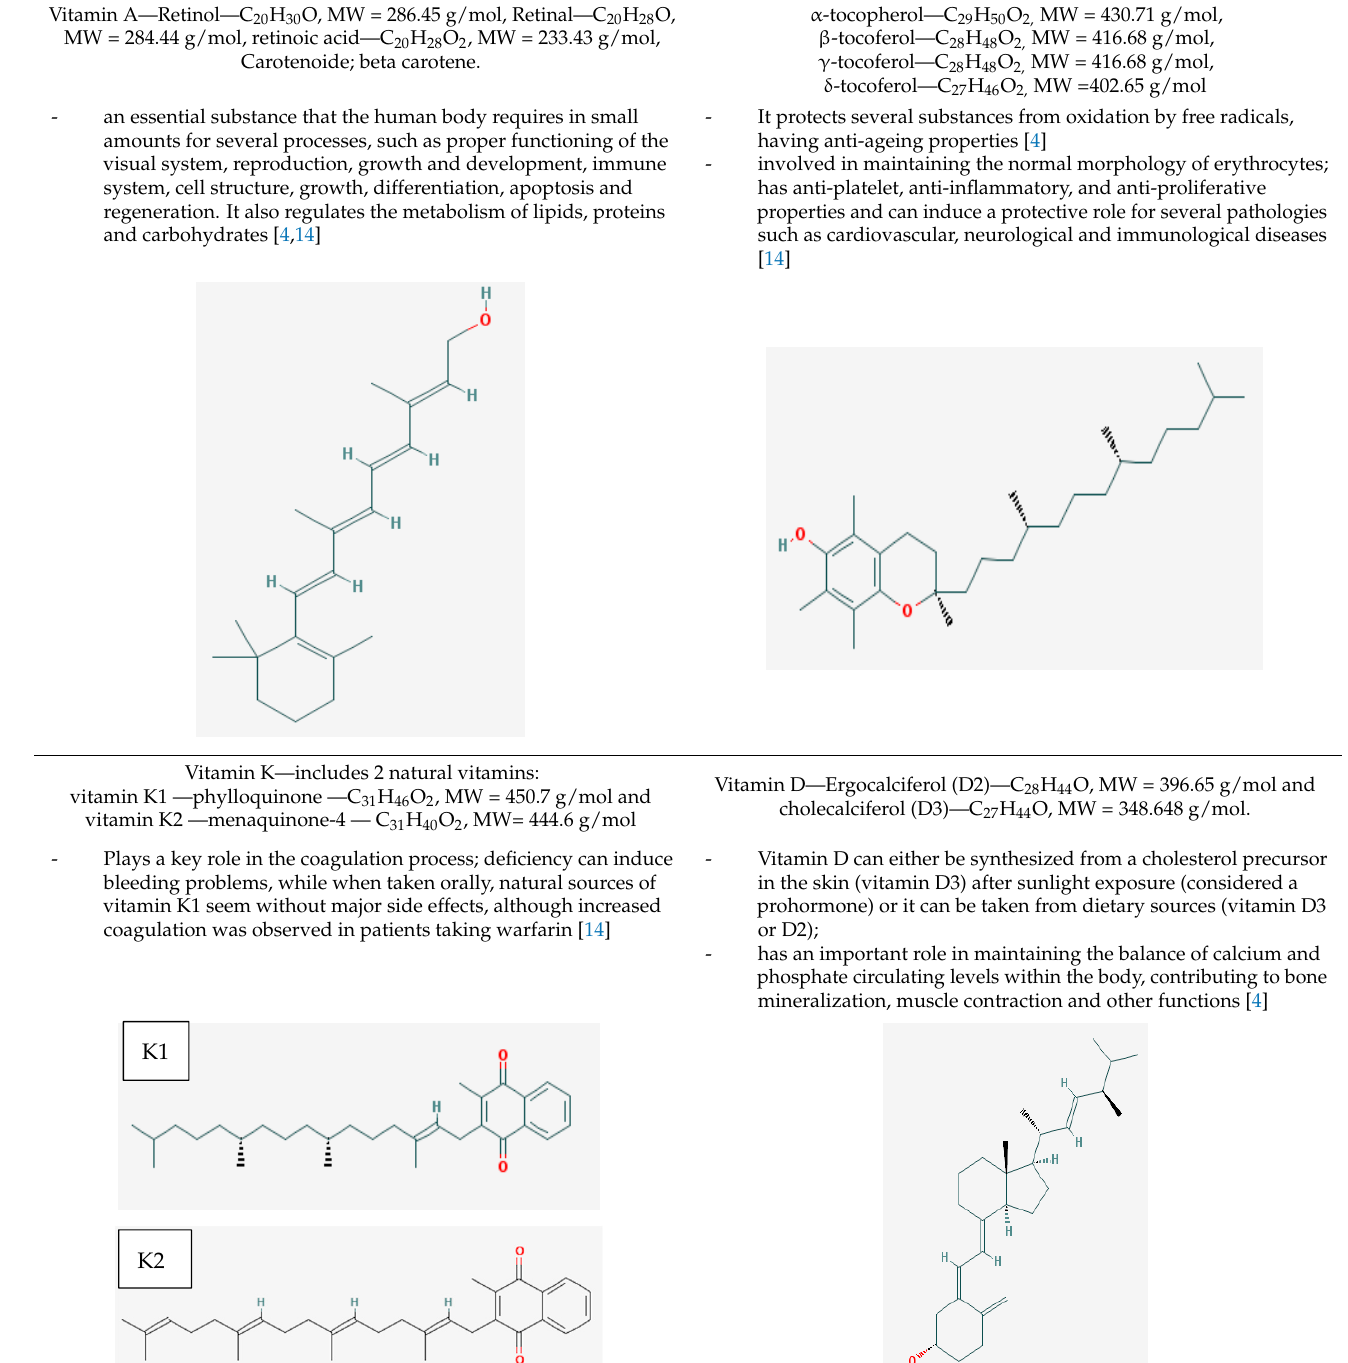
Table 1. Cont. Hydro-Soluble Vitamins Lipo-soluble